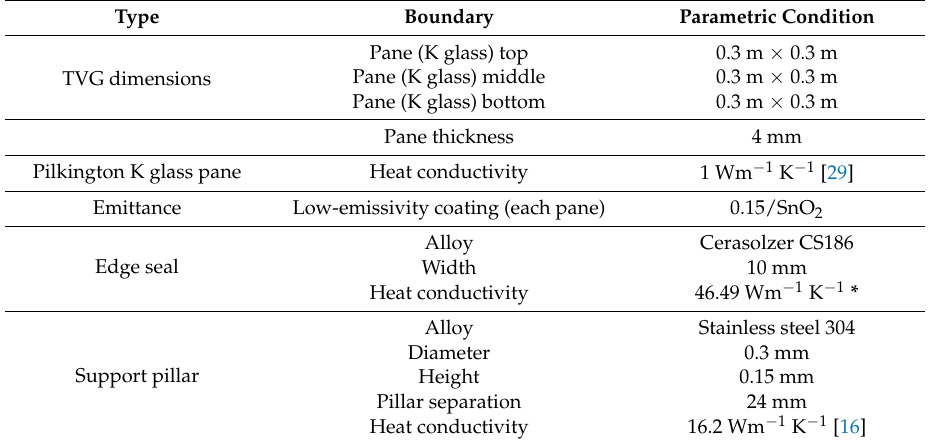
Table 1. Constructional boundary elements of the 10-mm wide edge-sealed TVG (Triple Vacuum Glazing).